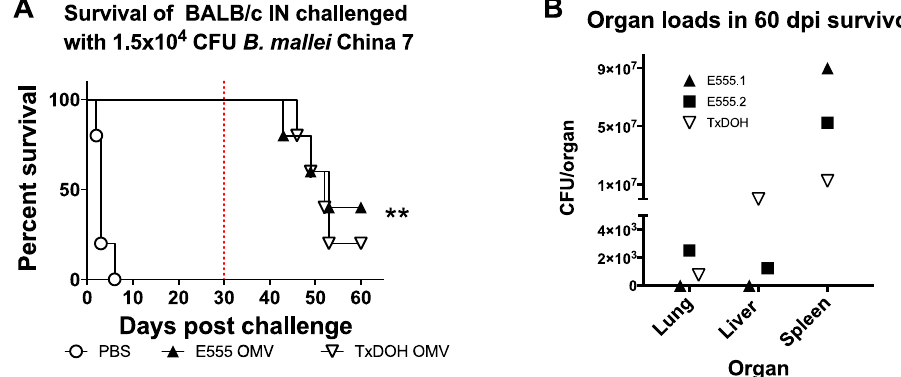
Figure 7. OMV vaccination protects BALB/c mice from chronic glanders following intranasal inoculation. ( A ) 4–6 weeks old BALB/c mice intranasally challenged with 1.5 × 10 4 CFU B. mallei China 7 after prime-boost-boost vaccination with E555-, TxDOH-derived OMV or PBS (each group n = 5) were observed for survival out to 60 days. Statistically significant increases in survival compared to PBS vaccinated mice were determined by the Log-rank (Mantel-Cox) test where ** p ≤ 0.01. The red-dashed line indicates an important milestone of 30 days post-infection. ( B ) Bacterial loads in the lungs, livers, and spleens of 60-day survivors.